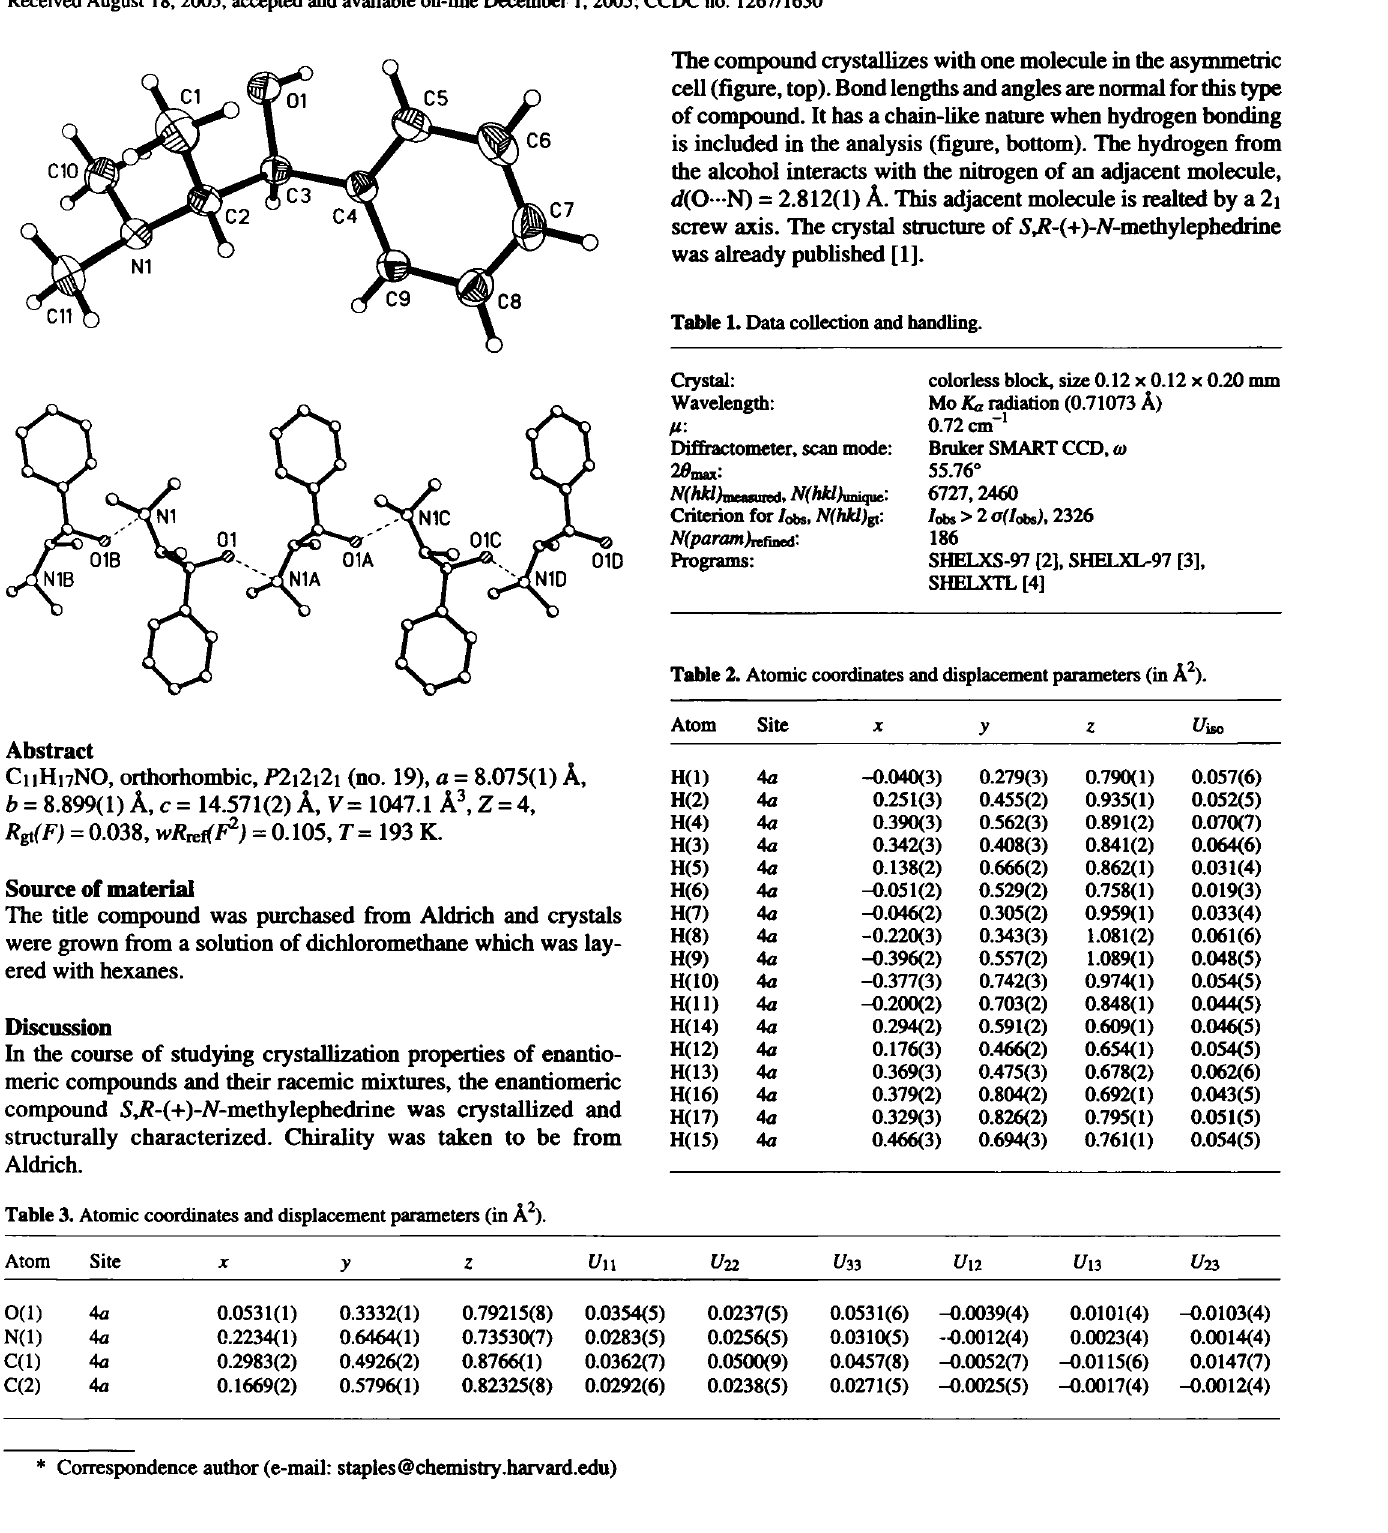
Table 3. Atomic coordinates and displacement parameters (in A 2 ).